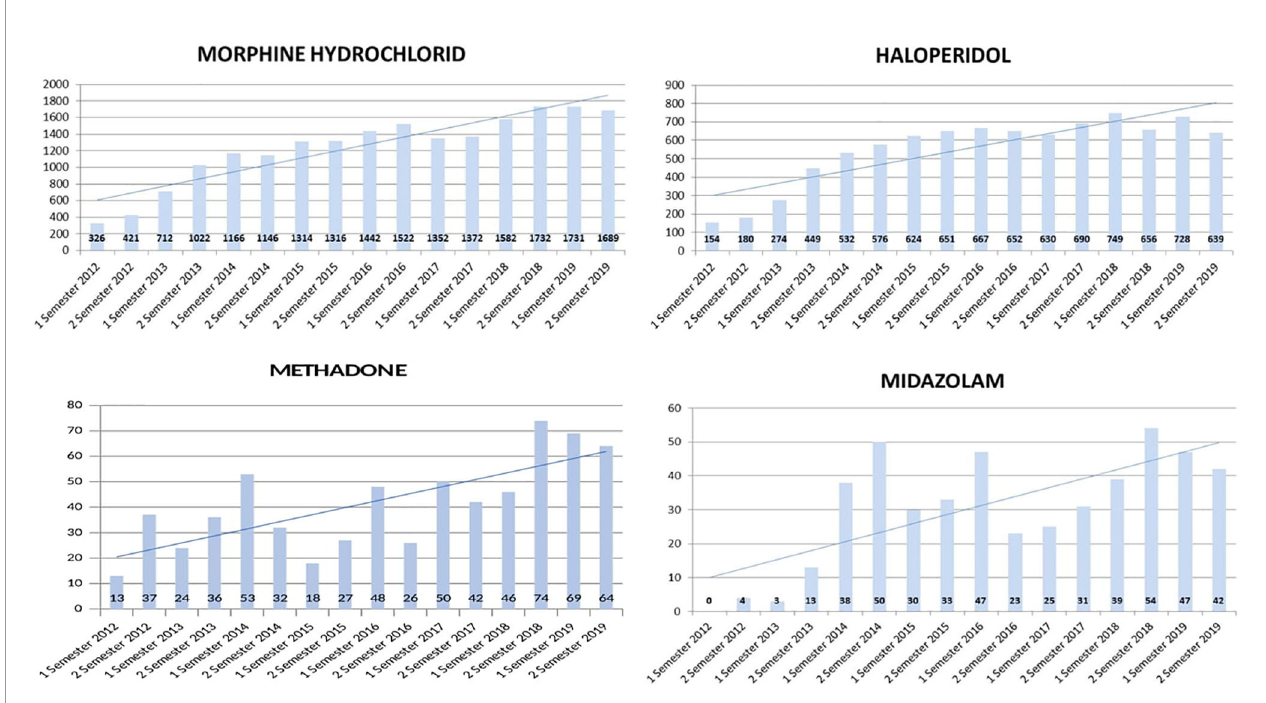
FIGURE 2 | Prescription volumes of morphine, haloperidol, methadone and